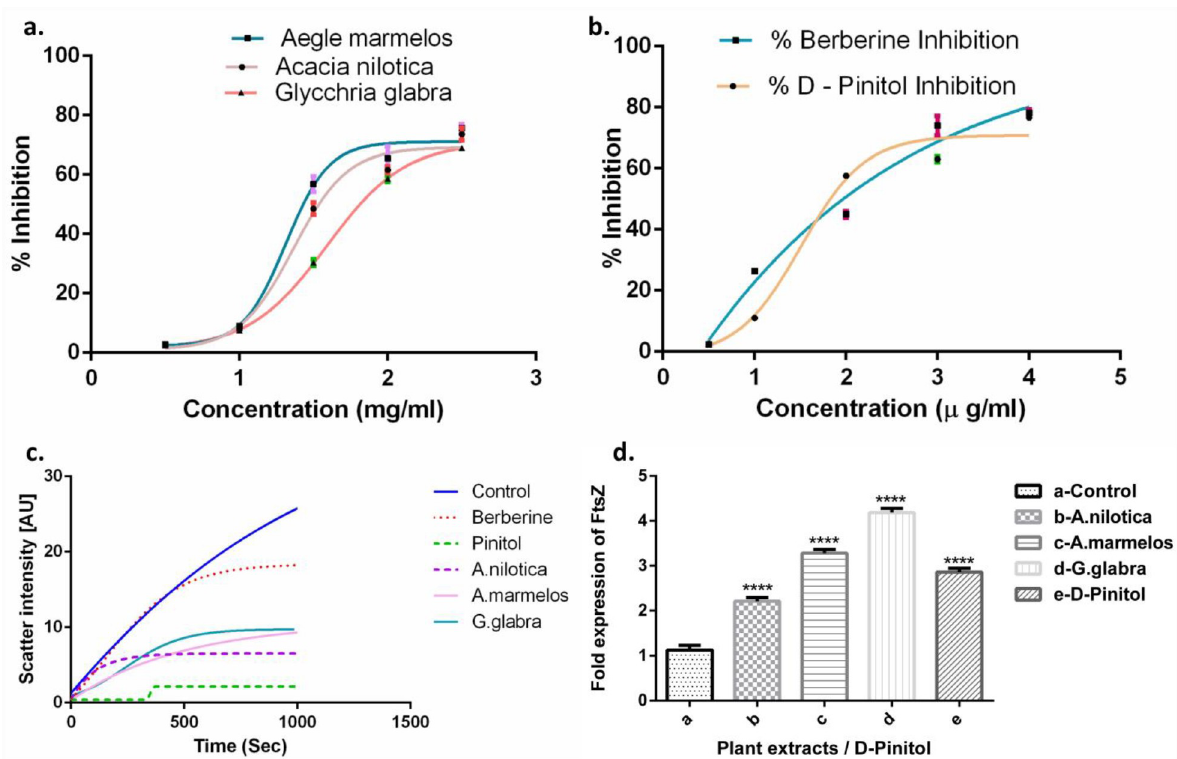
Fig 6. Effect of a) HXM extracts (mg/mL) and b) D-Pinitol ( μ M) on M . smegmatis FtsZ - GTPase polymerisation activity. c) FtsZ polymerisation activity measured using 90 ο light scattering assay at 1.5 x MIC with FtsZ at 12 μ M. Each point represents the mean of three different replicates, d) RT–PCR Gene expression analysis—fold increase in the expression of FtsZ post treatment at 1.5 x MIC. P = ���� < (0.0001) when compared with the